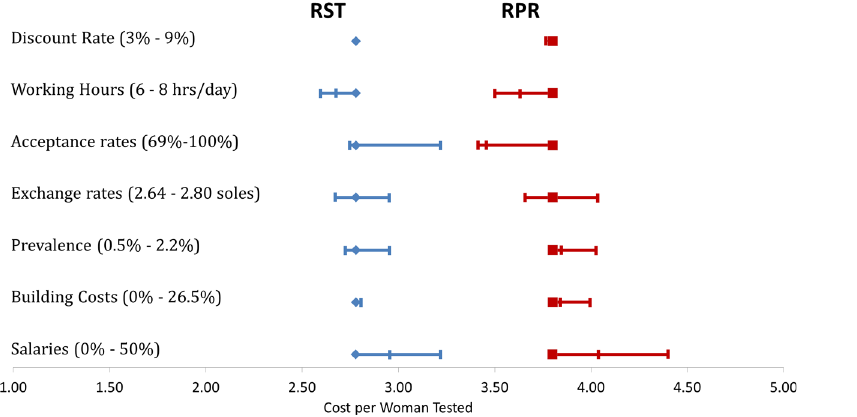
Fig 3. Univariate sensitivity